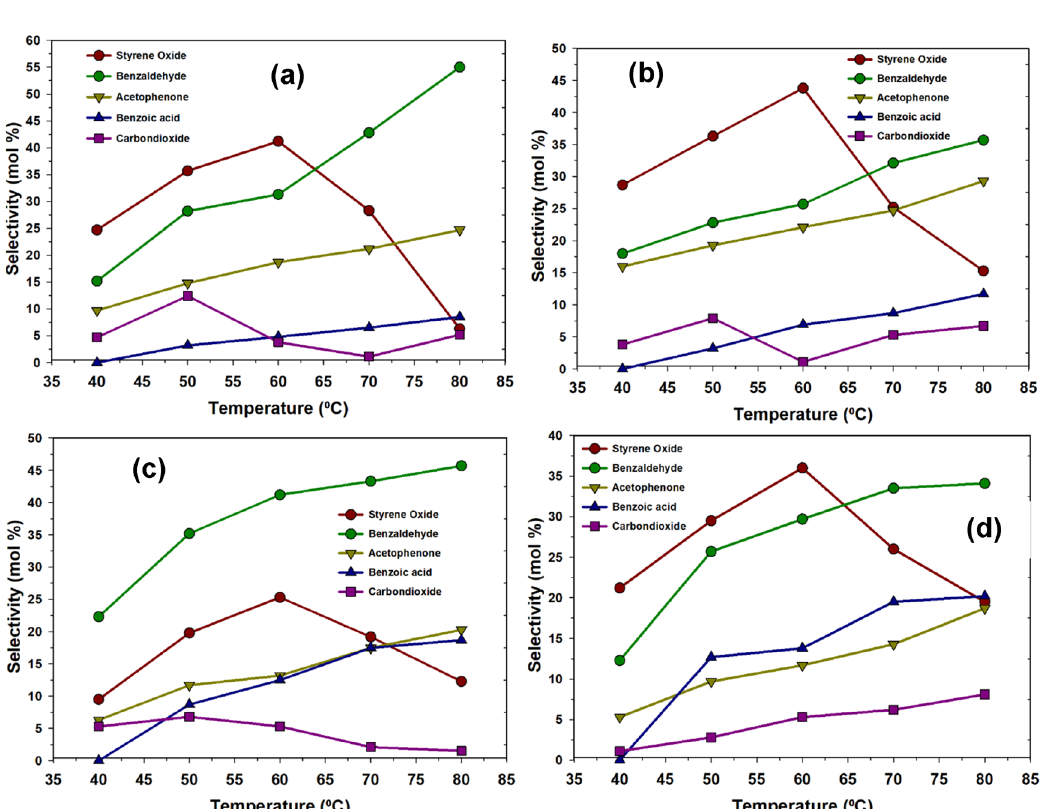
Figure 7. Effect of the temperature on the selectivity towards products in the oxidation of styrene over ( a ) Ru-Pth, ( b ) Ru-Pth-Me, ( c ) Ni-Pth and ( d ) Cu-Pth complexes under UV radiation. Reaction conditions: catalyst: styrene (1:100); styrene to H 2 O 2 ratio of 1; acetonitrile: 50 ml; reaction time: 3